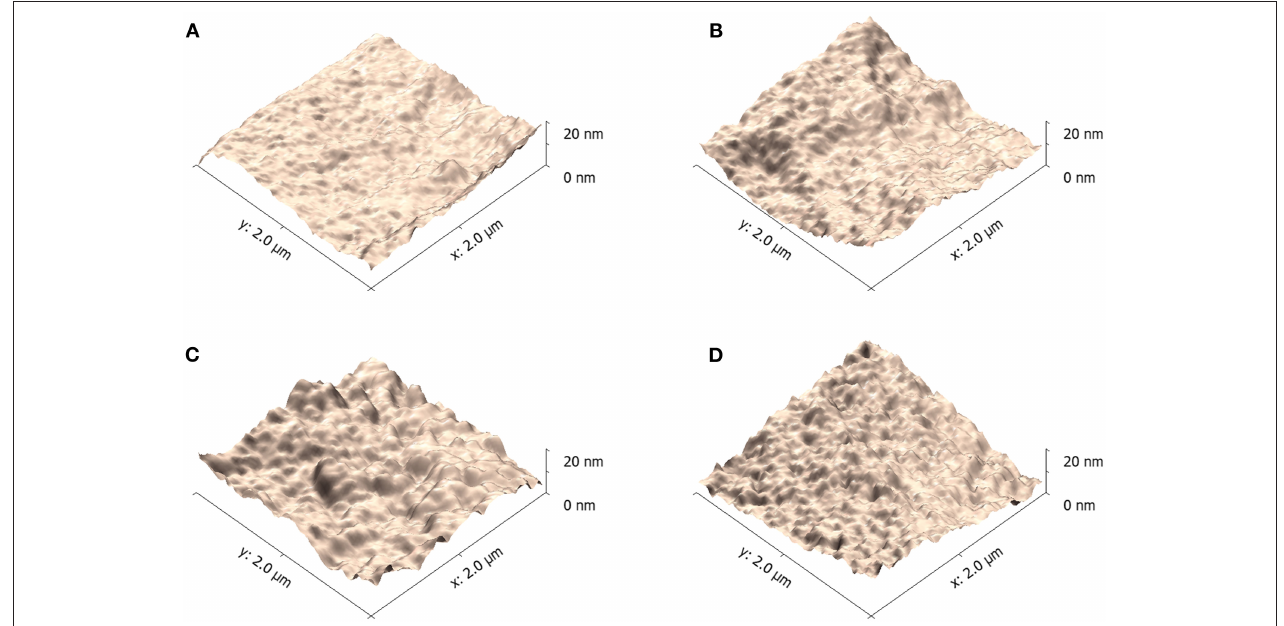
FIGURE 7 | Atomic force microscope (AFM) (2 µ m × 2 µ m scale) imaging for PBDB-T-2Cl:IT4F blend films using varied solvents. (A) 100% CB, (B) 80% CB + 20% benzene, (C) 80% CB + 20% TMB, and (D) 80% CB + 0%